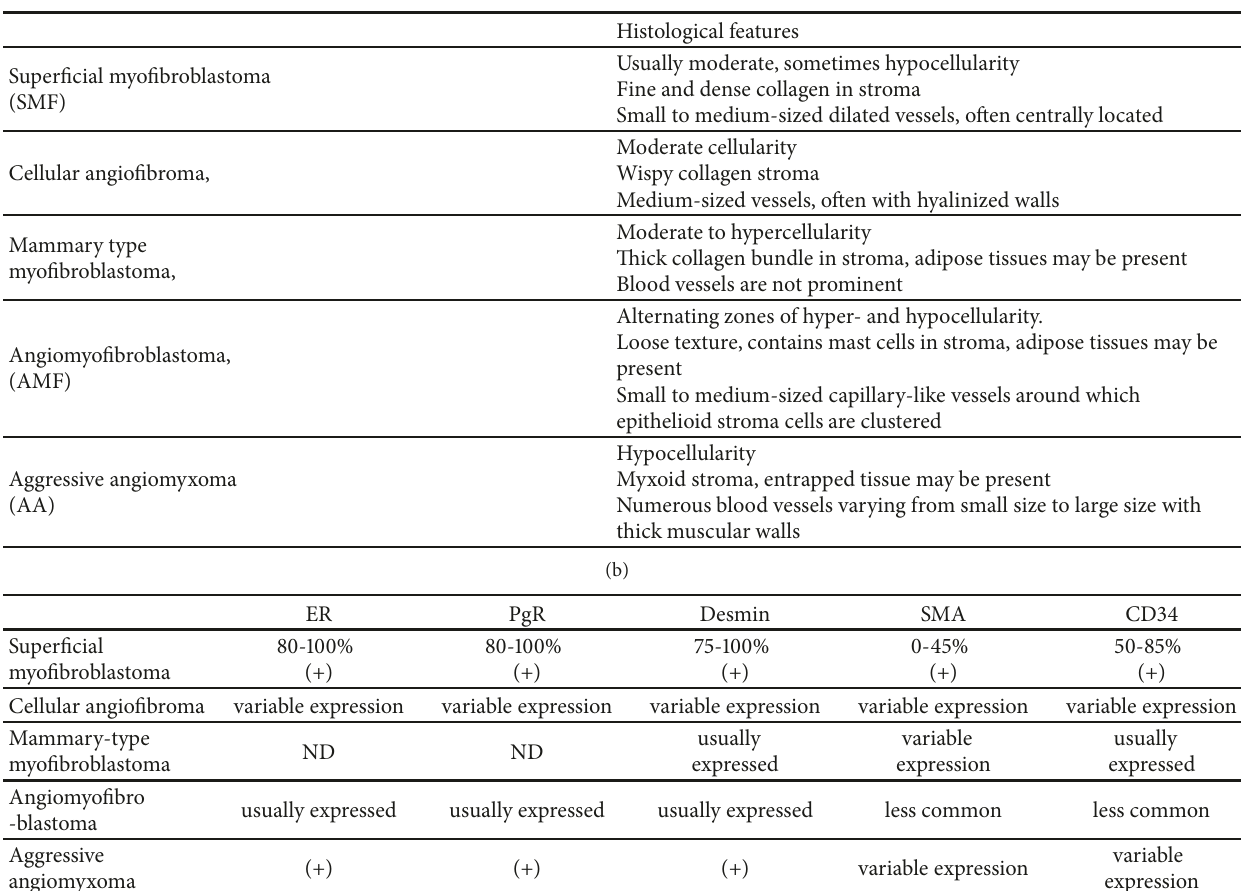
Table 2: Pathological features of SMF and other mesenchymal